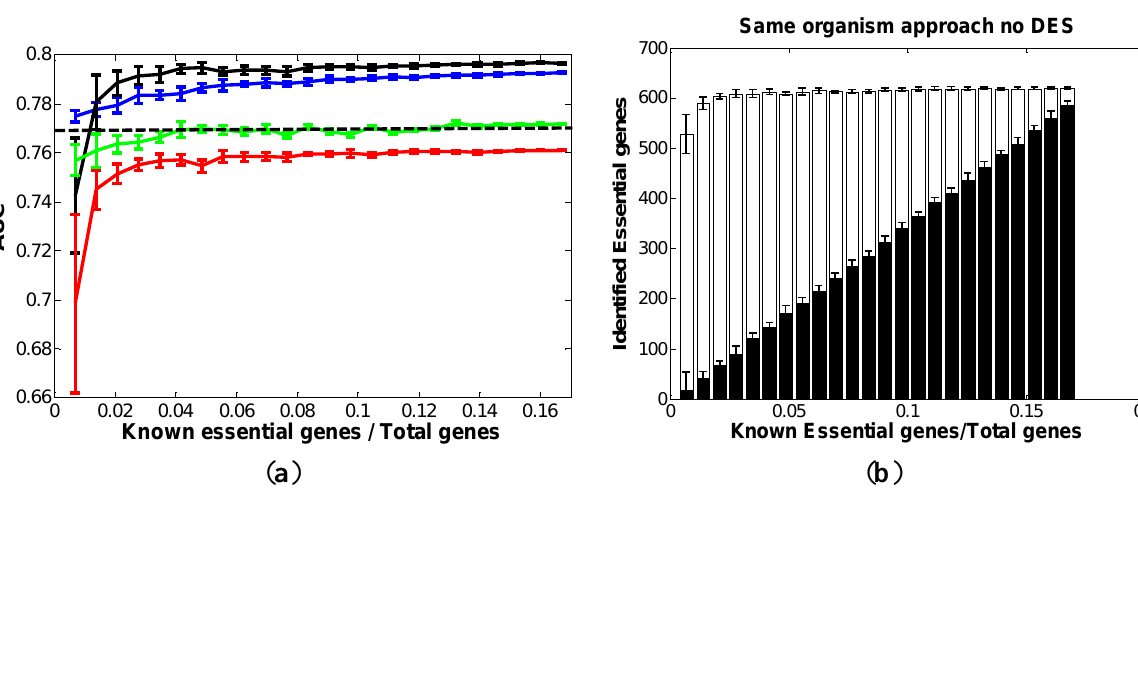
Figure 4. Comparison of three approaches in NC. ( a ) The distribution of AUC along with the different sizes of known essential genes in NC : red curve: same-organism approach “with no-DES”; black curve: same-organism approach “with DES”; blue curve: combined approach; dashed line: cross-organism approach. The bar chart of the correctly classified essential genes among the top 1500 predictions with respect to the different sizes of known essential genes in NC using ( b ) “no-DES” model; ( c ) “with-DES” model; and ( d ) combined model. The black bar shows the correctly classified essential genes in the “gold standard”